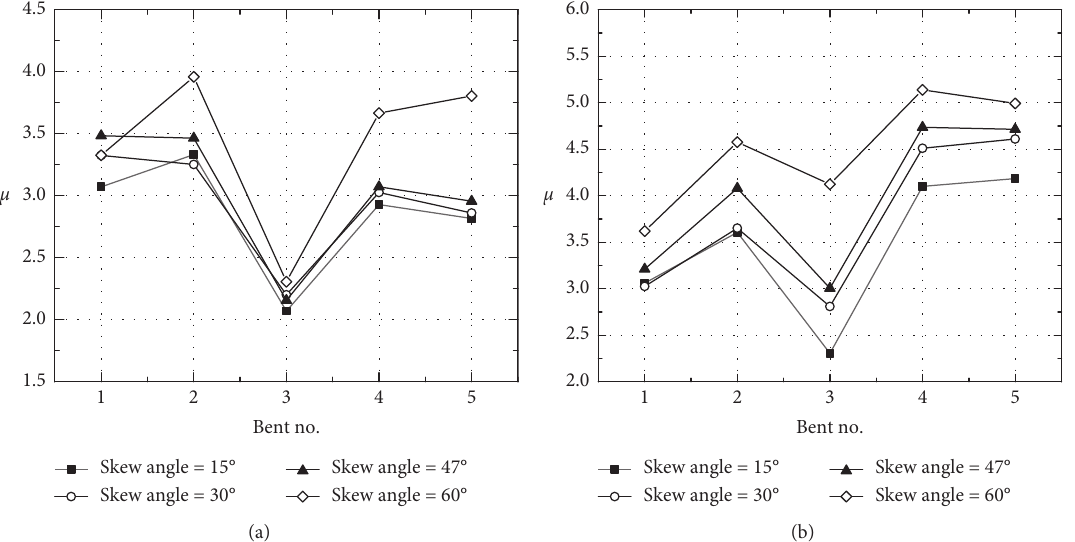
Figure 17: Displacement ductility demands of bridge models with different skew angles. (a) Longitudinal direction. (b) Transverse